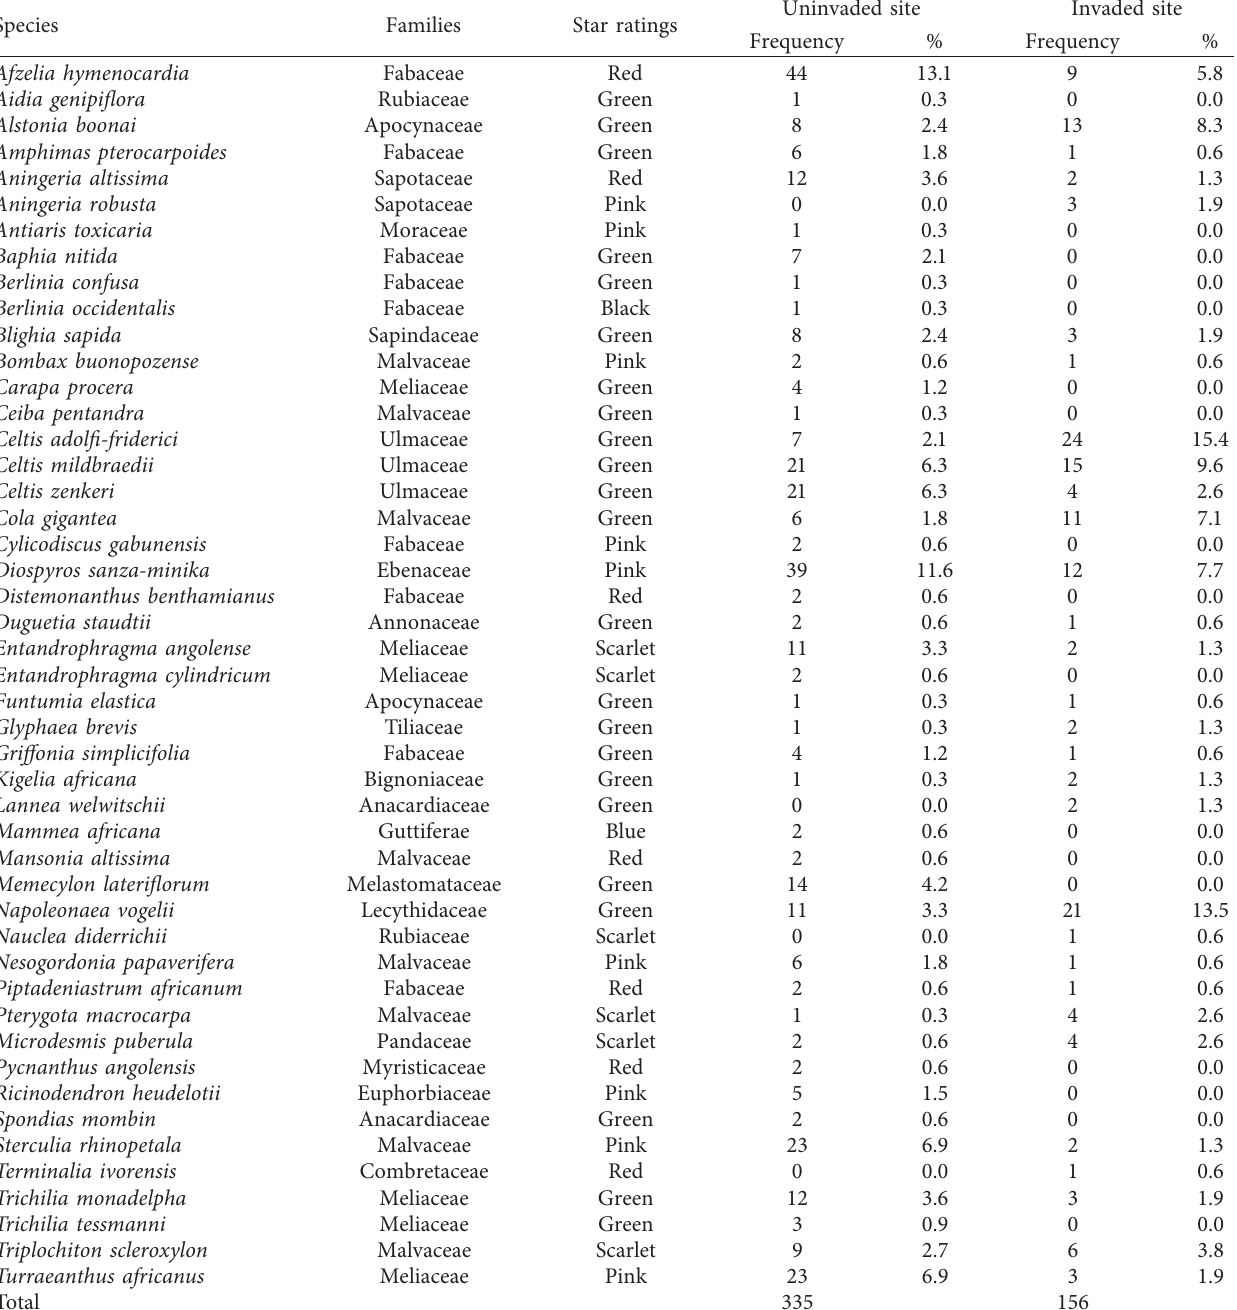
Table 2: Naturally regenerated tree species on study